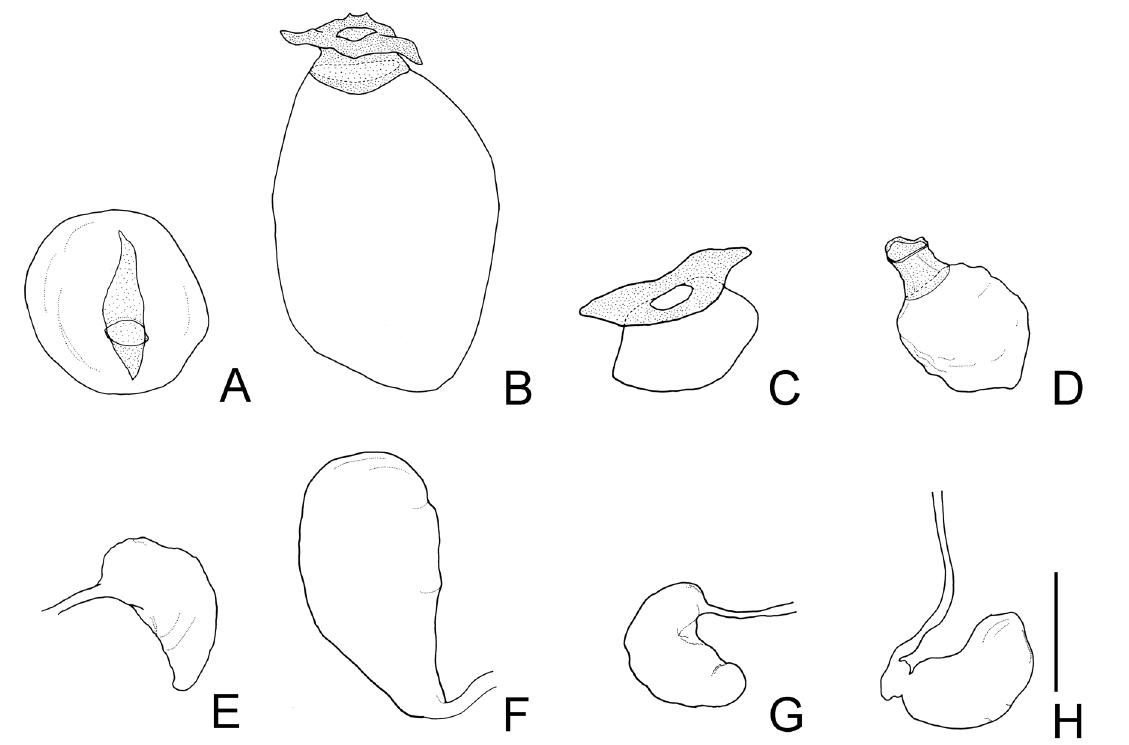
Fig. 11. Female genital organs of subgenus Neogeorissus spp. A–D . Bursal sclerite. E–H .